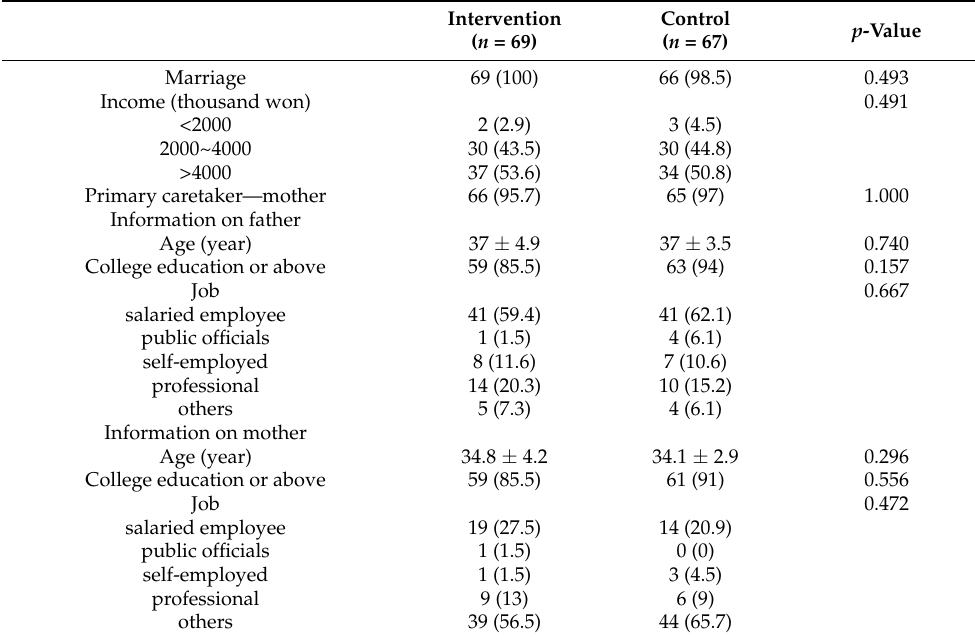
Table 2. Socioeconomic characteristics of very preterm infants.